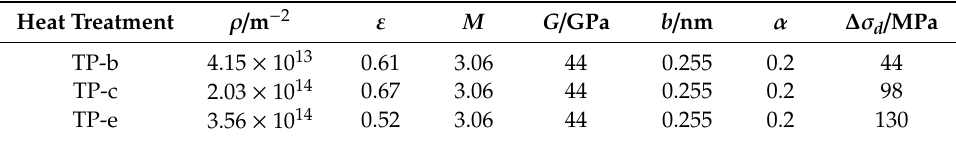
Table 9. Relevant parameters and calculated results of the work hardening.